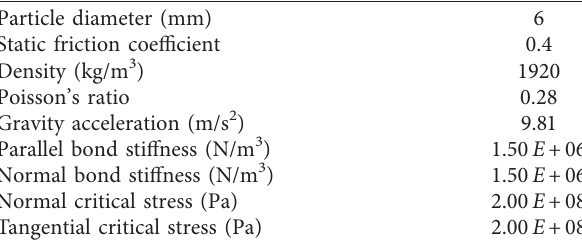
Figure 2: Model after particle filling. Table 1: Particle simulation parameters.